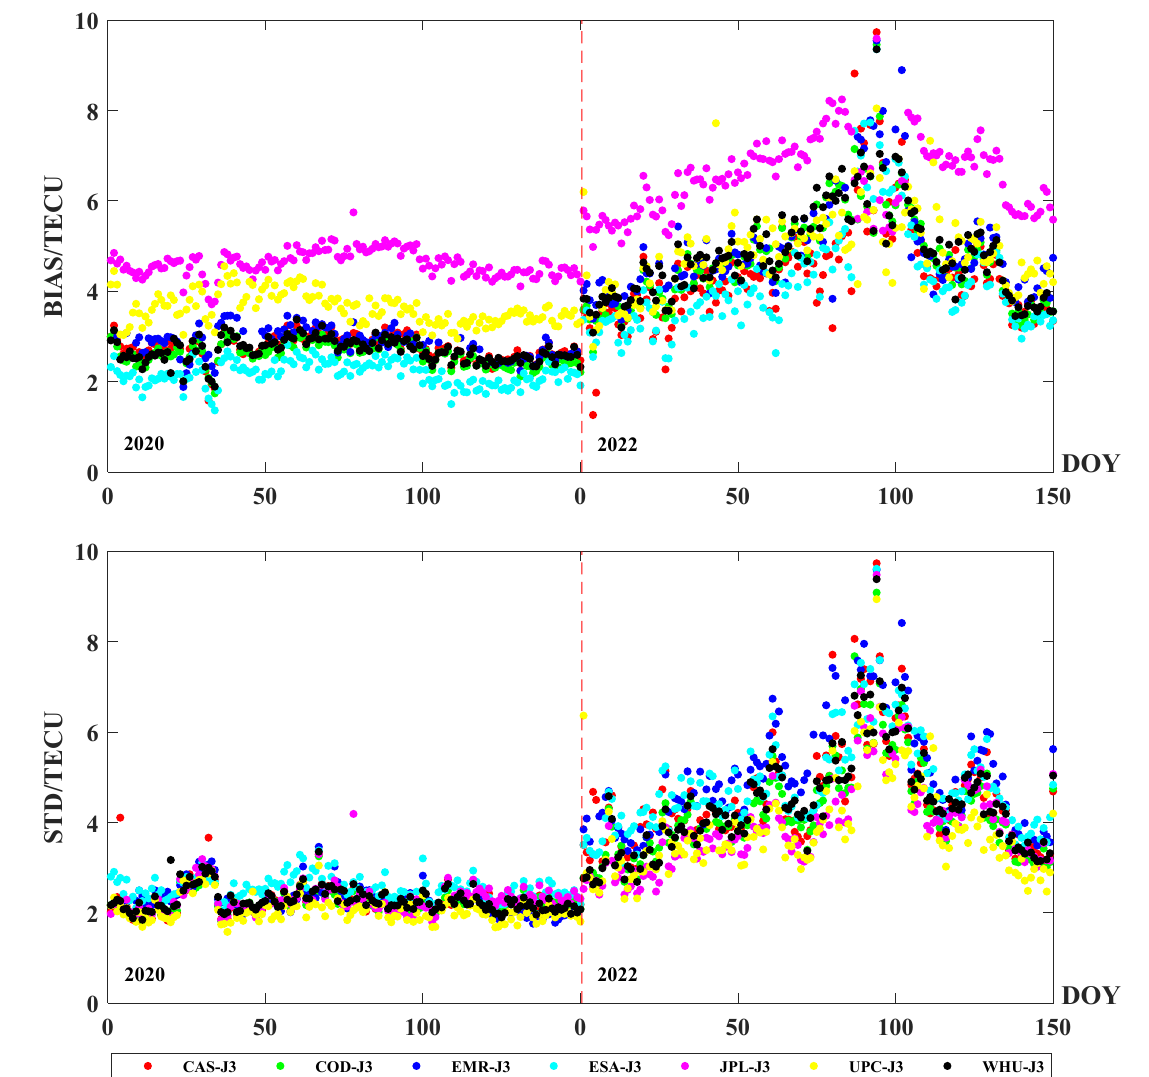
Figure 6. Time series figure of bias and STD of GIMs and Jason-3 altimeter satellite. Table 3. Accuracy statistics of GIM versus Jason3 for different institutions in the units of TECu.